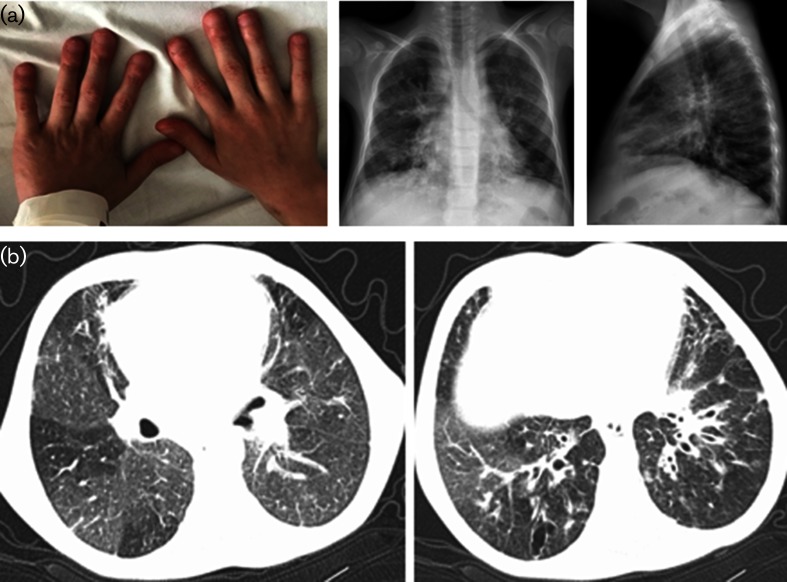
(a) Clubbing and chest X-ray of Patient 1 (at 9 years of age): bilateral heterogeneous ill-defined lung infiltrations with peribronchial thickening. Air trapping on lateral chest X-ray. Mediastinal widening due to lymphadenomegaly. (b) Thorax CT of Patient 1 (at 9 years of age): bilateral mosaic perfusion defect with basal bronchial wall thickening and bronchiectasis.